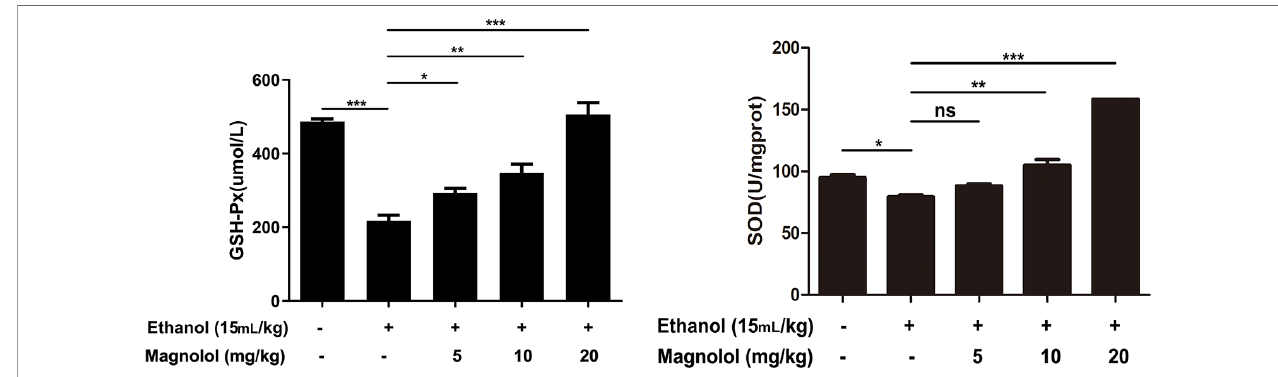
FIGURE 3 | Effects of magnolol on mice alcohol-induced liver damage in SOD and GSH-Px level. Before alcohol was gavaged, magnolol was given for 3 days. We took the liver tissue to measure SOD and GSH-Px. The date is presented as mean ± SD. (*P < 0.05, **P < 0.01, ***P < 0.001and "ns" means not signi fi cant).